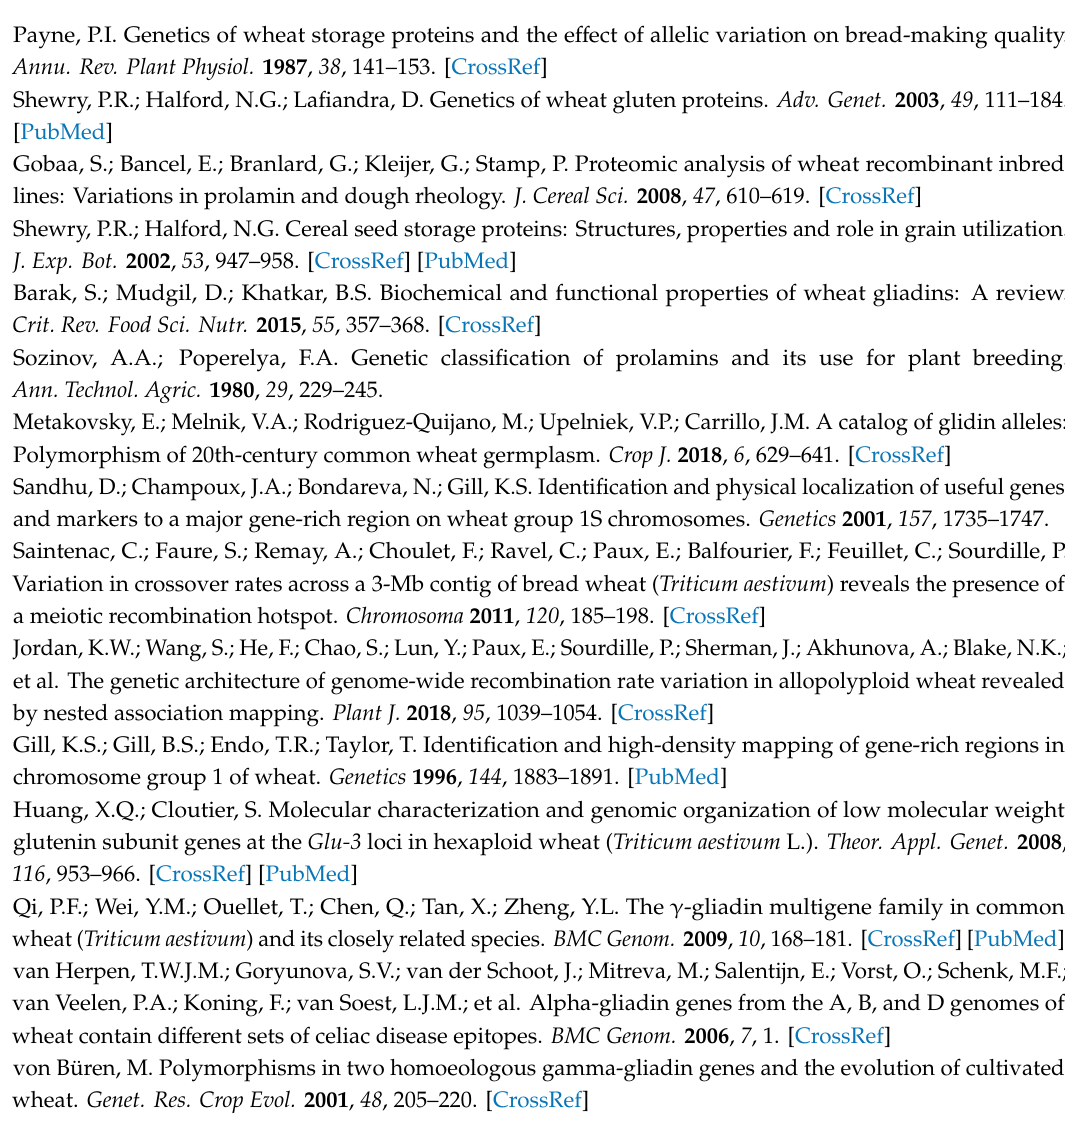
Figure S1: Scheme of sets of gliadin polypeptides (blocks) produced by allelic variants studied of the Gli-B1 locus. ω -Gliadins encoded by the allele Gli-B5b are shown. B, the electrophoregram and scheme of its electrophoretic bands of the standard cultivar